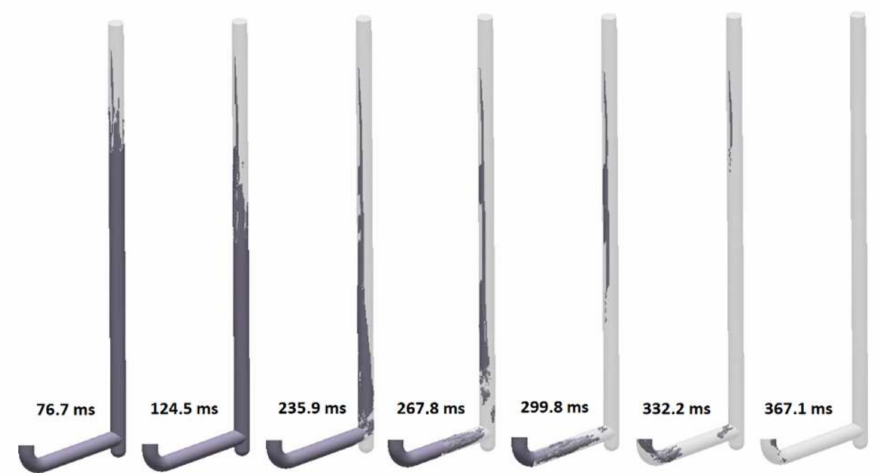
Figure 23. Air evacuation in round, non-tapered sprue with well (S s 4), MAGMASOFT.